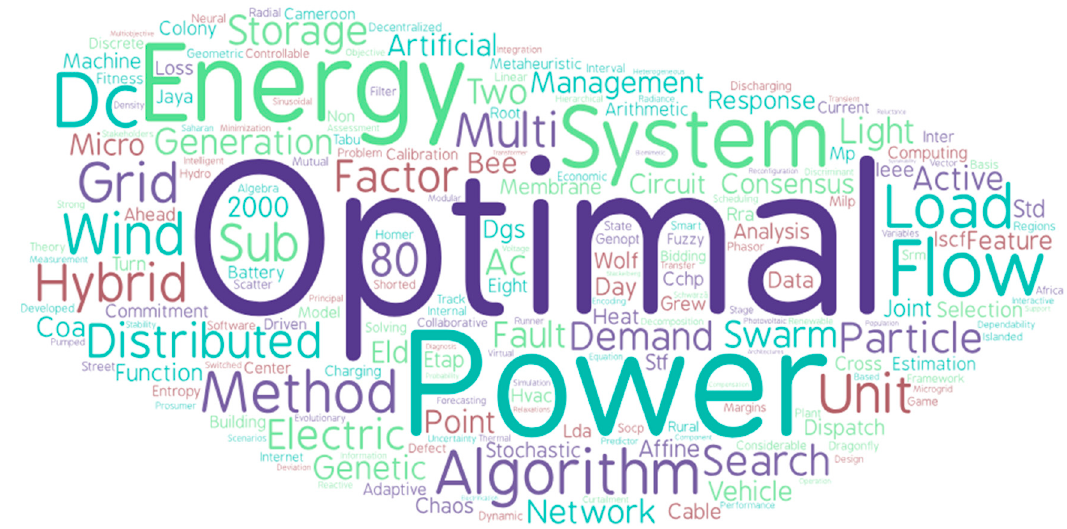
Figure 2. Cloud word for split author keywords related to the special issue.